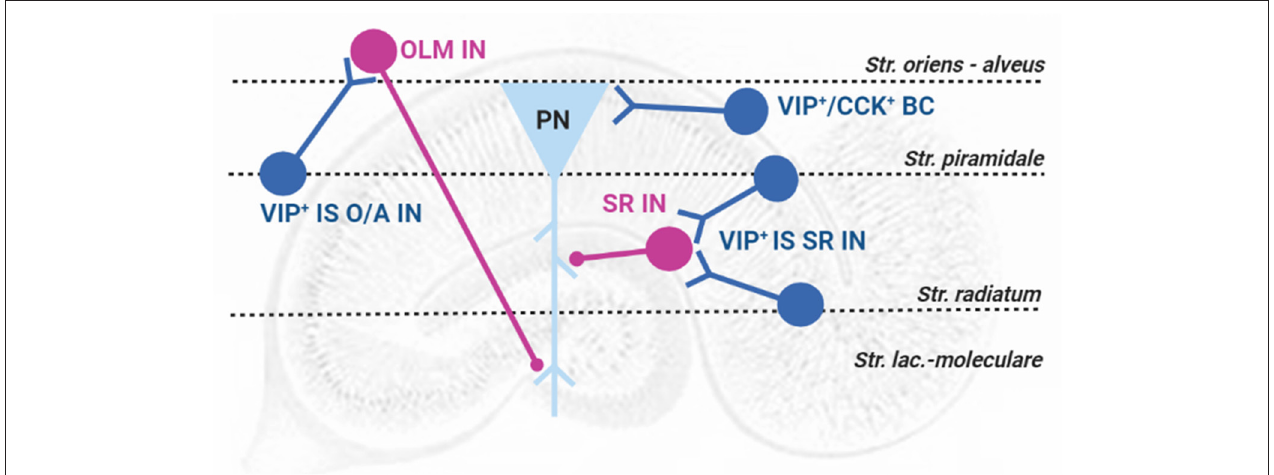
FIGURE 1 | Representation of VIP-containing interneurons in the rat hippocampus: layer location and target selectivity. PN, pyramidal neuron (triangle, light blue); Interneurons (circles, pink); VIP-containing interneurons (circles, blue); VIP + -CCK + BCs : VIP-containing basket cells ; VIP + IS O/A IN : VIP-containing interneuron-selective interneuron targeting the stratum oriens / Alveus and VIP + IS SR IN : VIP-containing interneuron-selective interneuron targeting the stratum radiatum ; OLM IN – Stratum oriens interneuron projecting to the Stratum lacunosum-moleculare ; SR IN – Stratum radiatum local interneurons. Str.: stratum .